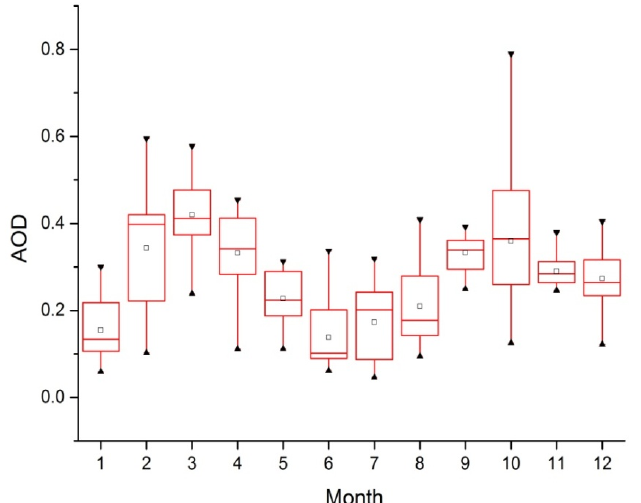
Figure 4. Monthly statistics of the aerosol optical depth (AOD) at 532 nm. The boxes represent the mean of the maximum and minimum for each month, the triangles represent the monthly maximum and minimum, and the short horizontal lines represent the monthly